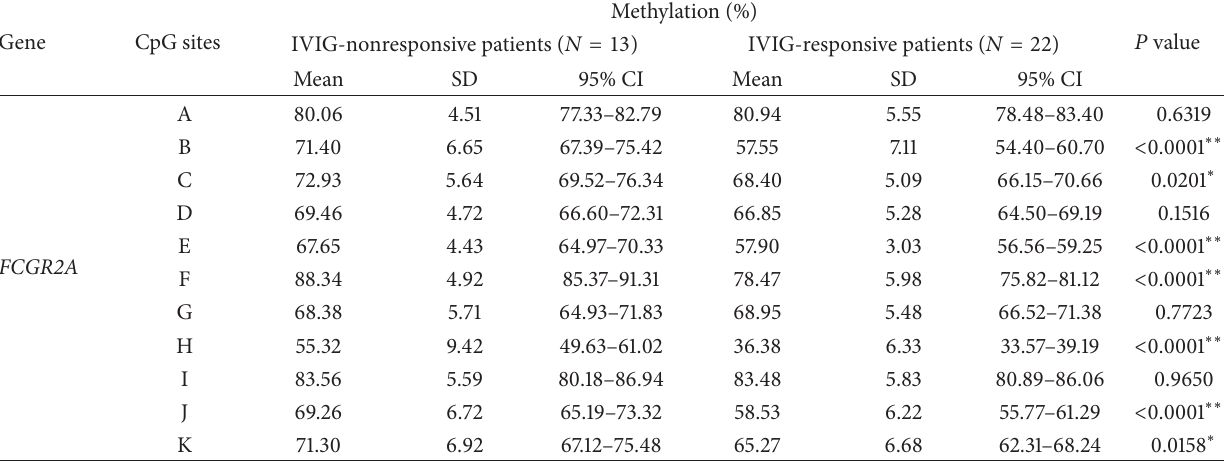
Table 3: Means and standard deviations of the percentage of methylation detected at each CpG site in KD patients responding or not responding to intravenous immunoglobulin treatment. Gene CpG